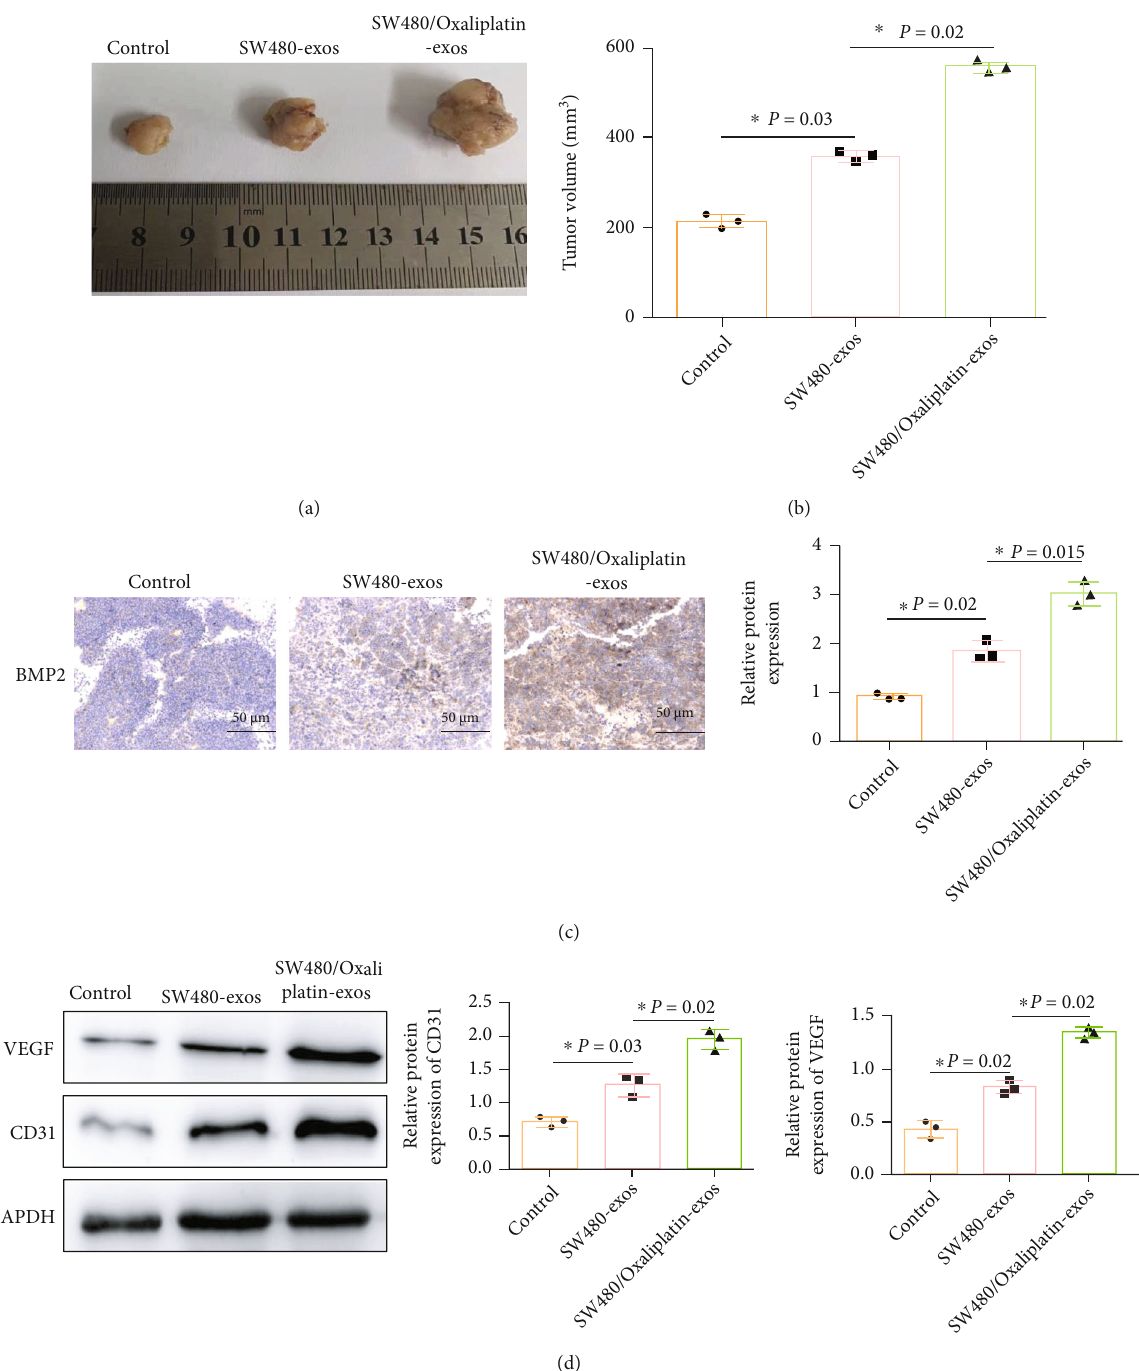
Figure 6: SW480/oxaliplatin exosomes promotes angiogenesis in vivo. BALB/c nude mice were injected with SW480 cells and SW480-exos or SW480/oxaliplatin-exos for 28 days ( n = 6 ). (a and b) The size and volume of the subcutaneous tumors in mice. (c) BMP-2 expression detected by immunohistochemical staining. (d) The protein expression of VEGF and CD31 in tumors. All above experiments were repeatedly performed 3 times; data are shown as the means ± SD . ∗ P < 0 : 05 , ∗∗ P < 0 : 01